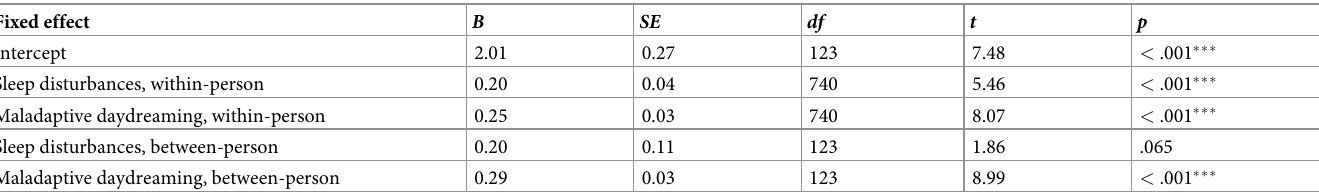
Table 4. Multilevel analyses with maladaptive daydreaming today and sleep last night as predictors of Mind wandering today. Fixed